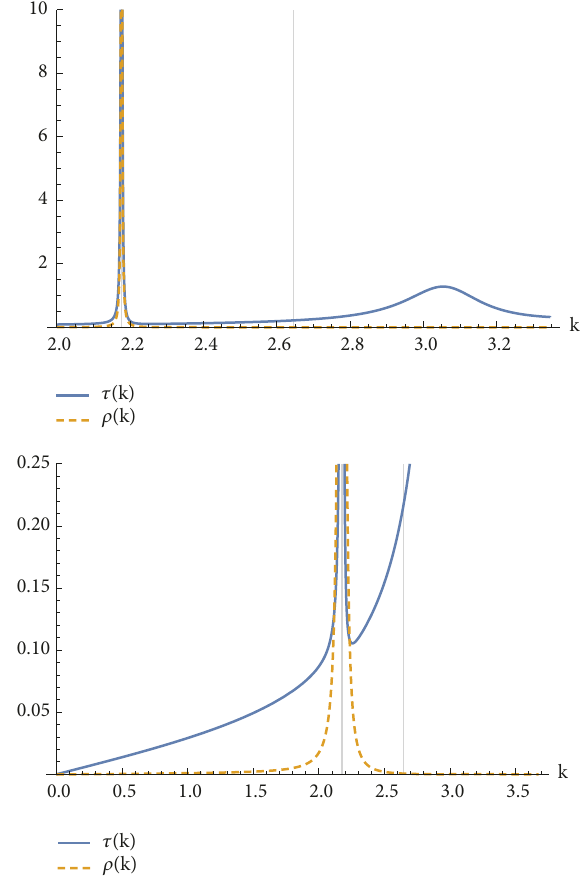
Figure 3: Top : the stationary transmission clock time 𝑡 𝑇 𝑐 (𝑘) (blue) and the wave number distribution 𝜌(𝑘) = |𝑆(𝑘)| 2 (orange, dashed, and arbitrary scale), for 𝑉 0 = 7 , 𝑎 = 1 , 𝑏 = 3 , and 𝑘 0 ≈ 2.175932 ), with the initial state given by (18). Bottom: close view of the above plot for small times. The vertical grey lines in the plots correspond to 𝑘 = 𝑘 0 and 𝑘 = √𝑉 0 . The regions in which 𝑡 𝑇󸀠 𝑐 (𝑘) ≈ 0 (around the local maximum and minimum of 𝑡 𝑇 𝑐 (𝑘) ) correspond to times 𝜏 ≈ 𝑡 𝑇 (𝑘 ) and 𝜏 ≈ 0.105 𝑎.𝑢. Rydberg atomic units were used in all the 0 𝑐